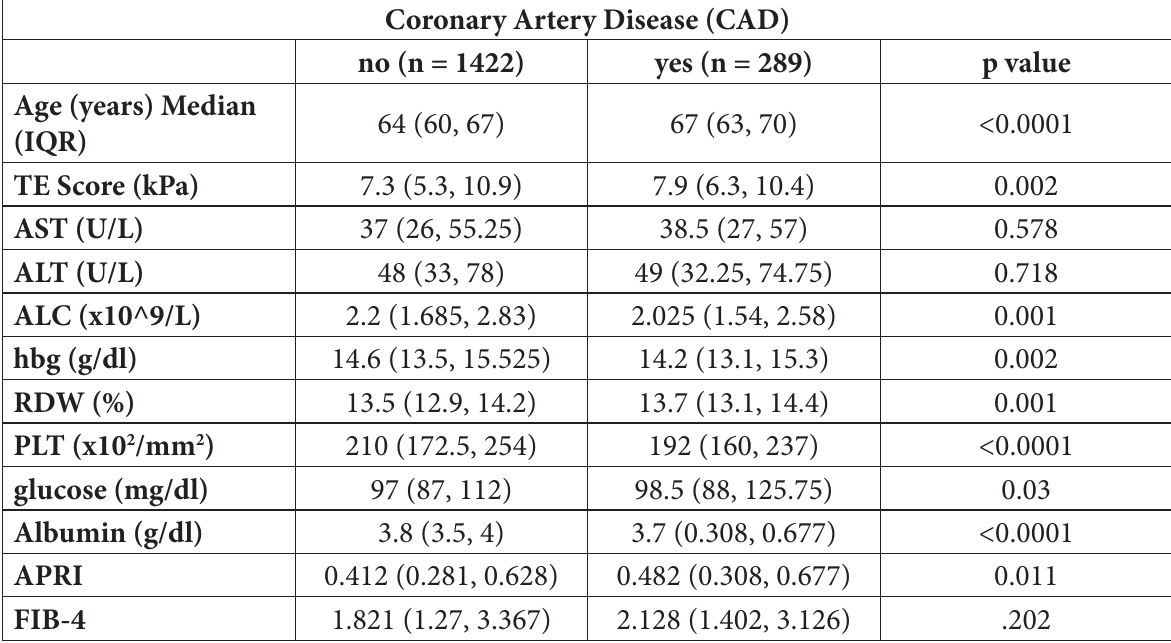
Table 2. Parameters at time of TE associated with CAD* Coronary Artery Disease